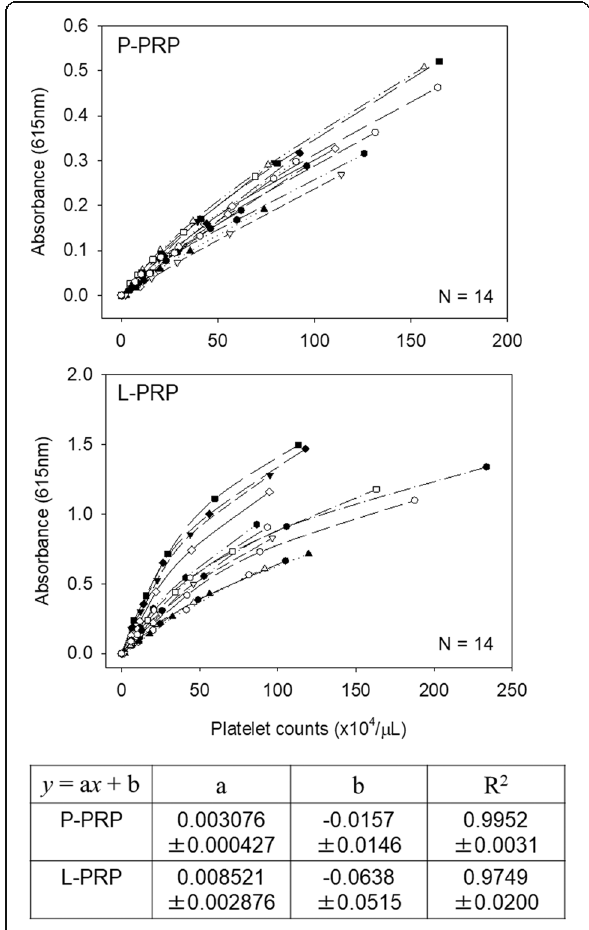
Fig. 4 Calibration curves of measured platelet counts versus absorbance in P-PRP and L-PRP preparations. The samples were serially diluted by PPP, and the platelet counts were determined using an AHA and SPM. N = 14 for each type of